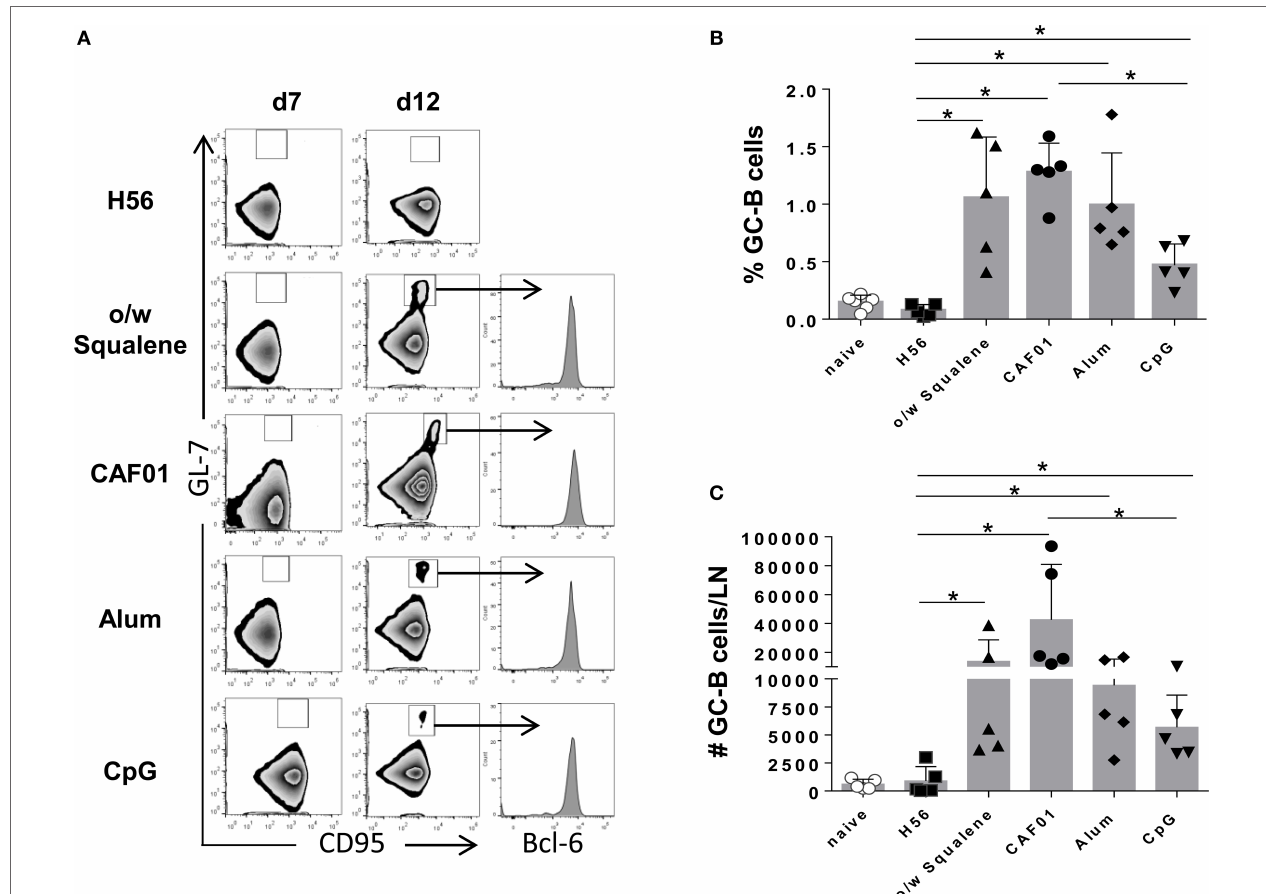
FigUre 7 | germinal center B cells induction . Mice were subcutaneously immunized with H56 alone (H56) or combined with different adjuvants (o/w squalene, CAF01, alum, and CpG), and draining lymph nodes were collected 7 and 12 days after immunization. (a) Germinal center B cells, identified as GL-7 + CD95 + among B220 + B cells in iliac lymph nodes 7 and 12 days after immunization. Intracellular Bcl-6 expression within germinal center B cells was analyzed and reported as histogram. Data are shown from a single animal representative of the group. (B,c) Frequencies of GC-B cells, with respect to B220 + B cells (B) and absolute numbers of GC-B cells per dLN (c) reported as mean ± SD of five mice per group. Mann–Whitney test, with Bonferroni correction for multiple pairwise comparisons, was used for assessing the statistical difference between each group immunized with adjuvant and the H56-immunized group. Kruskal–Wallis test, followed by Dunn’s post test for multiple comparisons, was used to assess the statistical difference between groups immunized with different adjuvants (* P ≤ 0.05).